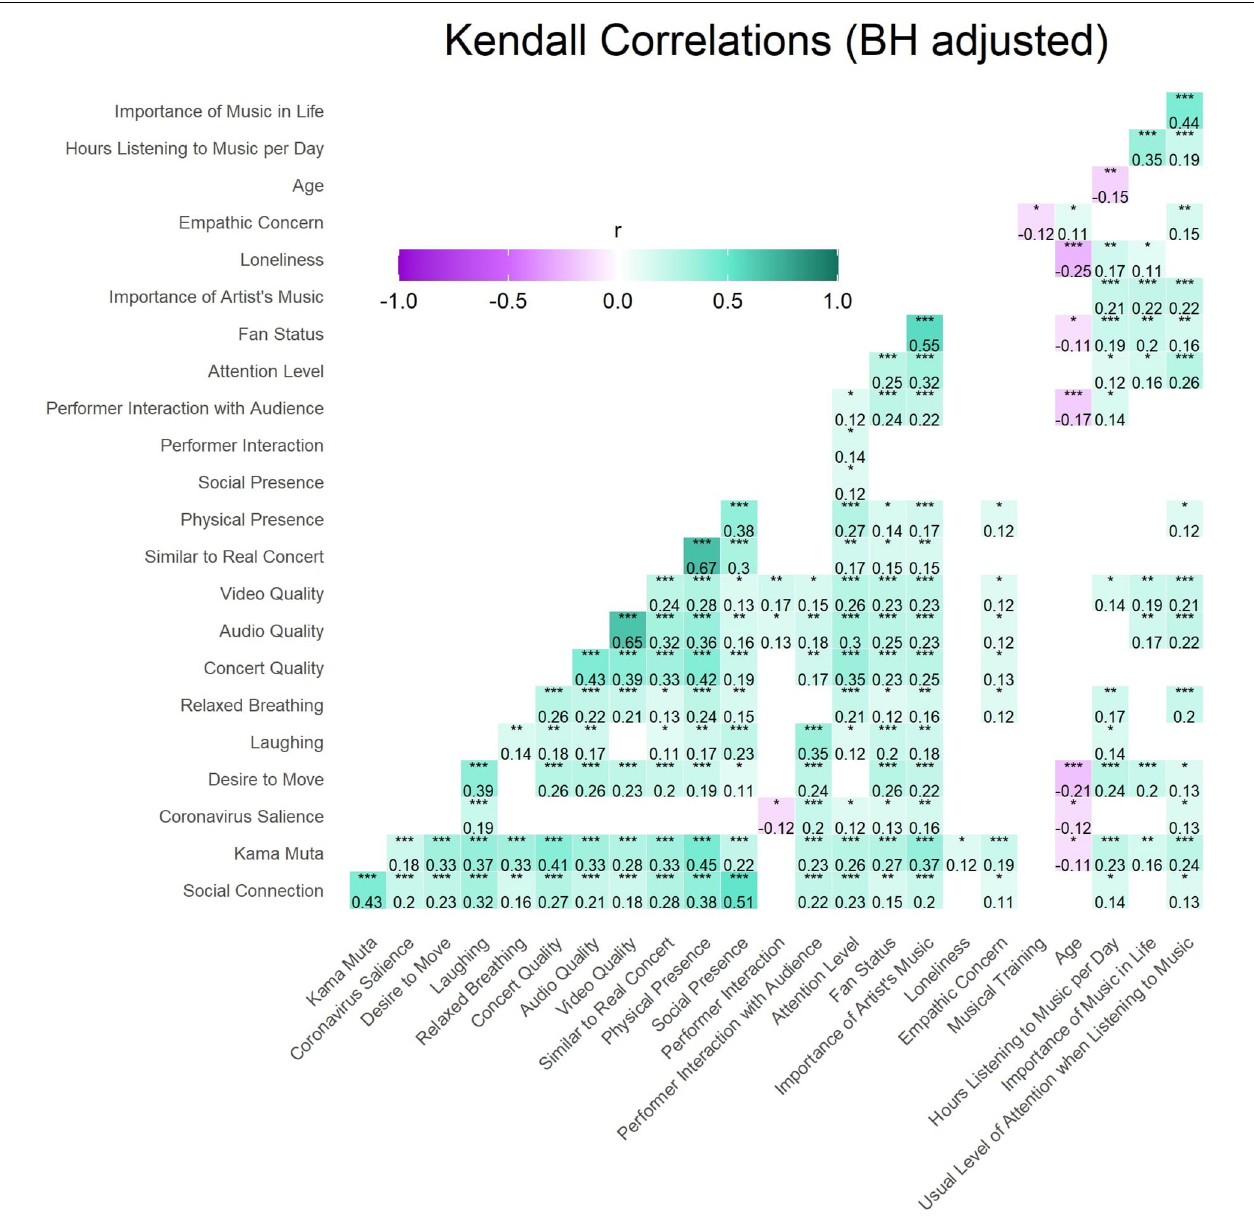
FIGURE 4 | Kendall correlations were performed across variables with information on the individual participants’ characteristics (personal importance of music in the past 3 years, hours listening to music per day, age, empathic concern, average loneliness since the beginning of the pandemic, fan status, attention level during the concert, the number of other people present in the same space) concert characteristics (how much the performers interacted with the audience and each other, the social and physical presence experienced by the participant at the concert, participants’ appraisal of if it was similar to a real concert, perceived video and audio quality, overall concert quality, and salience of the coronavirus), and feelings or behaviors that the participant experienced at the concert (laughing out loud, desire to move, kama muta , and social connection). To control for false detection rate, the BH method was used. Only significant correlations are shown, thus the number of others present is not displayed because it had no significant correlations. Recall that the correlation between social connection and social presence is partially driven by the fact that these scales share two items. ∗ p < 0.05, ∗∗ p < 0.01, ∗∗∗ p < 0.001.